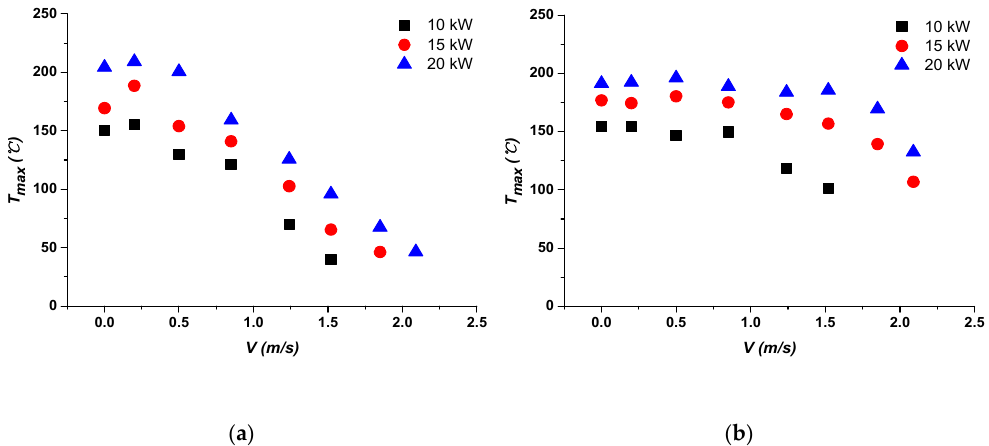
Figure 6. The maximum temperature under the ceiling of the corridor: ( a ) fully open to the environment; ( b ) partially open to the environment.